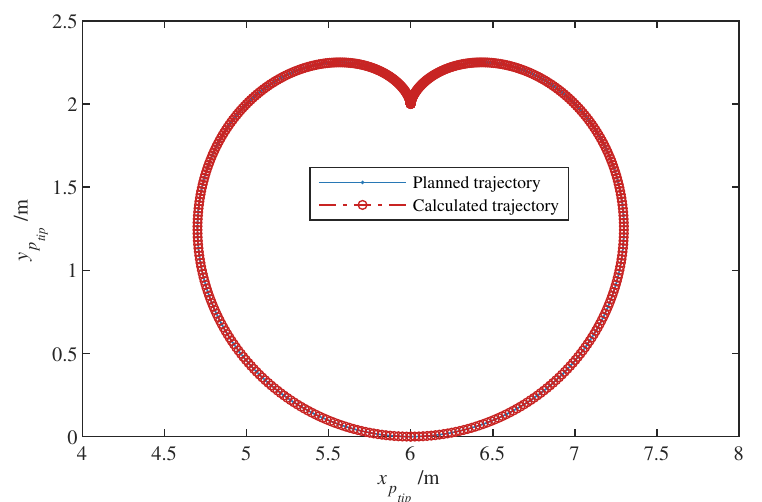
Figure 10. Comparison between calculated trajectory and planned trajectory of bucket tip P tip .